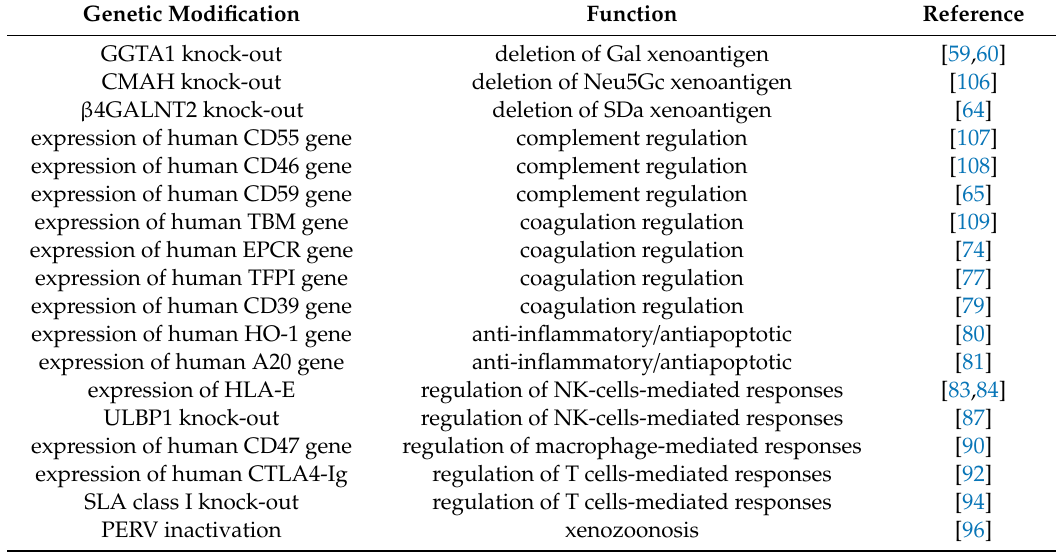
Table 4. Selected genetically engineered pigs for